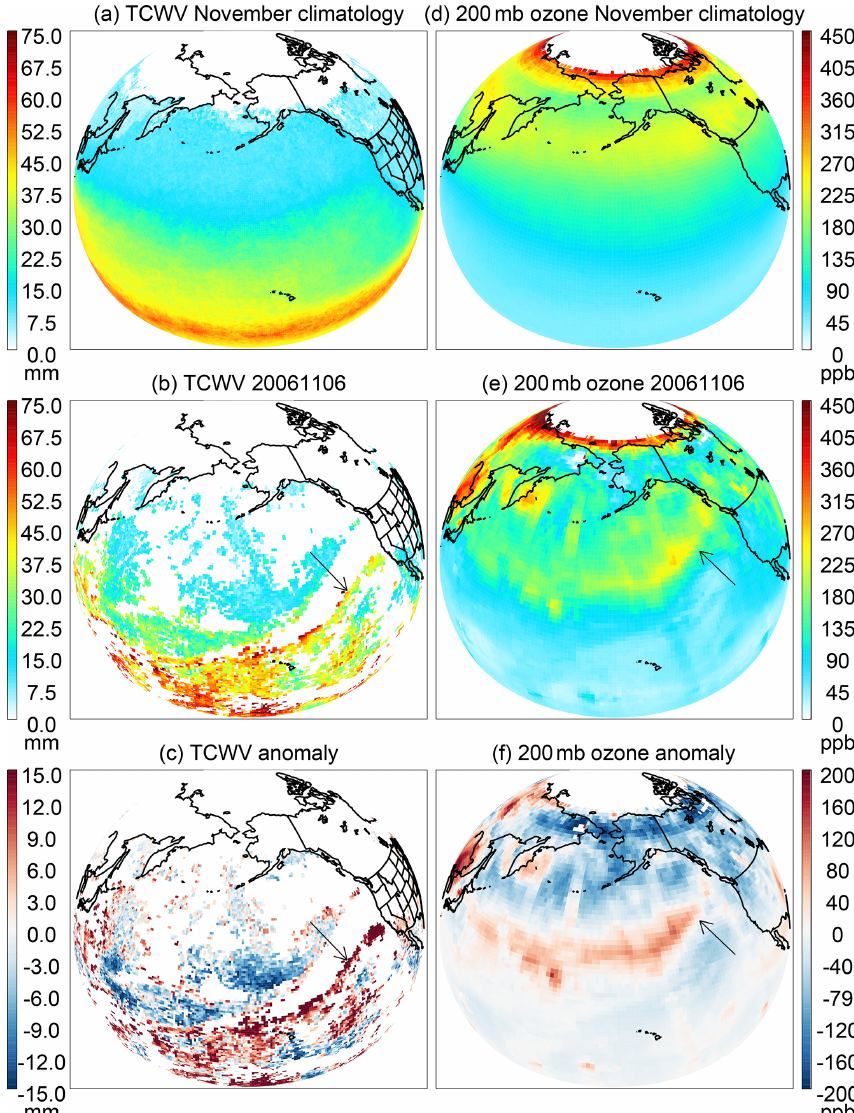
Figure 10. The Level 3 (a, d) climatology, (b, e) data on 6 November 2006 and (c, f) anomaly on 6 November 2006 with respect to the climatology for (a, b, c) version 4.0 OMI TCWV (mm; 0 . 5 ◦ × 0 . 5 ◦ ) and (d, e, f) the OMI ozone mixing ratio (ppb; 1 ◦ × 1 ◦ ) interpolated to